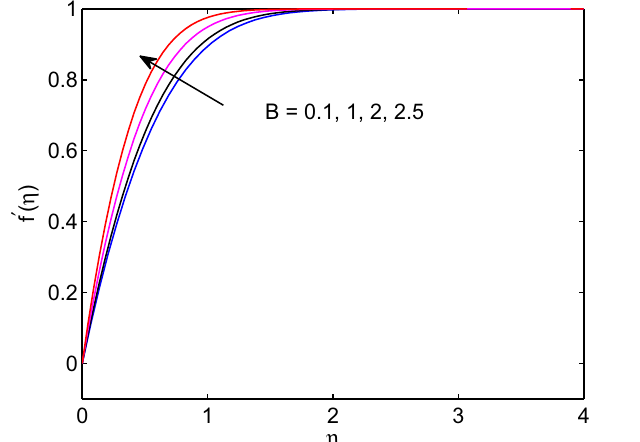
Figure 6. Melting heat transfer effects on velocity